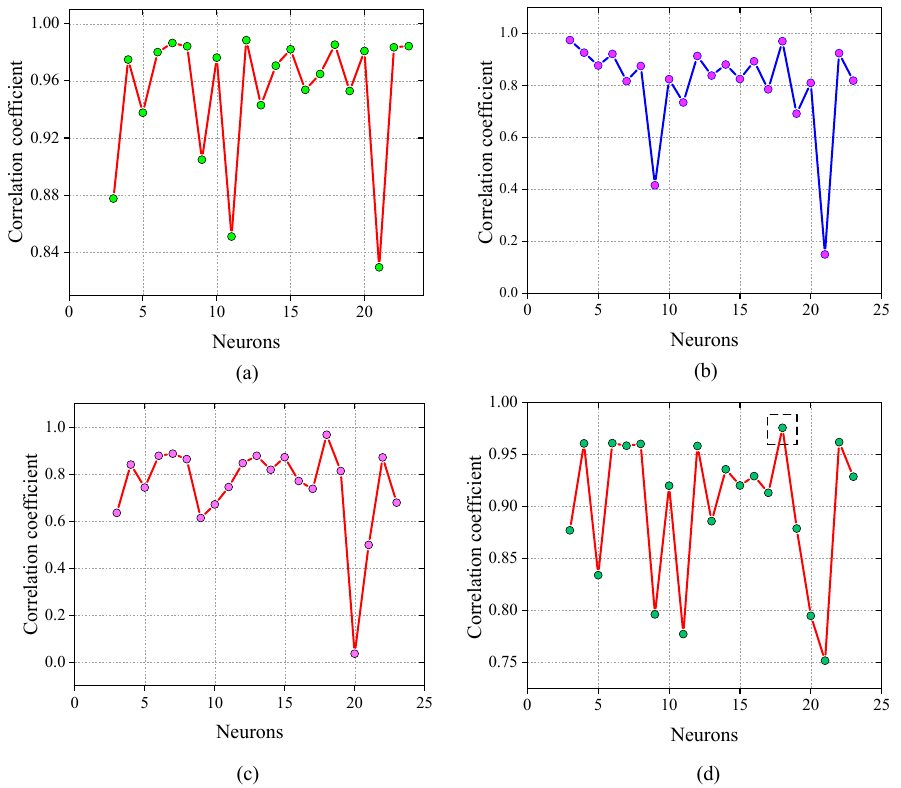
Figure 4. Selection of best neuron based on R-value (normalized values) ( a ) Training, ( b ) Validation, ( c ) Testing and ( d ) All dataset. The plot between the mean squared error and neurons is presented in Figure 5. The plots of the training, validation, testing, and all datasets are shown in Figure 5a, 5b, 5c and 5d, respectively. According to the mean squared values, 18 neurons were chosen as the best neurons, as shown in Figure 5d, and marked with a dotted square box.